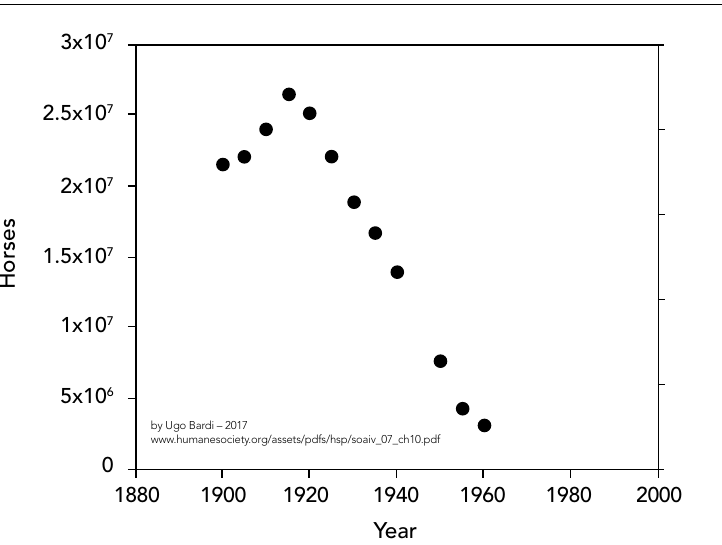
Figure 4. Horse population in the United States (data source: The Humane Society, http://www.humanesociety.org/assets/pdfs/hsp/soaiv_07_ch10.pdf). We see how the horse population went down rapidly and abruptly, from a maximum of more than 26 million in 1915, to about 3 million in 1960. Today their population has increased again to levels of the order of 10 million, but has not regained the level of the earlier